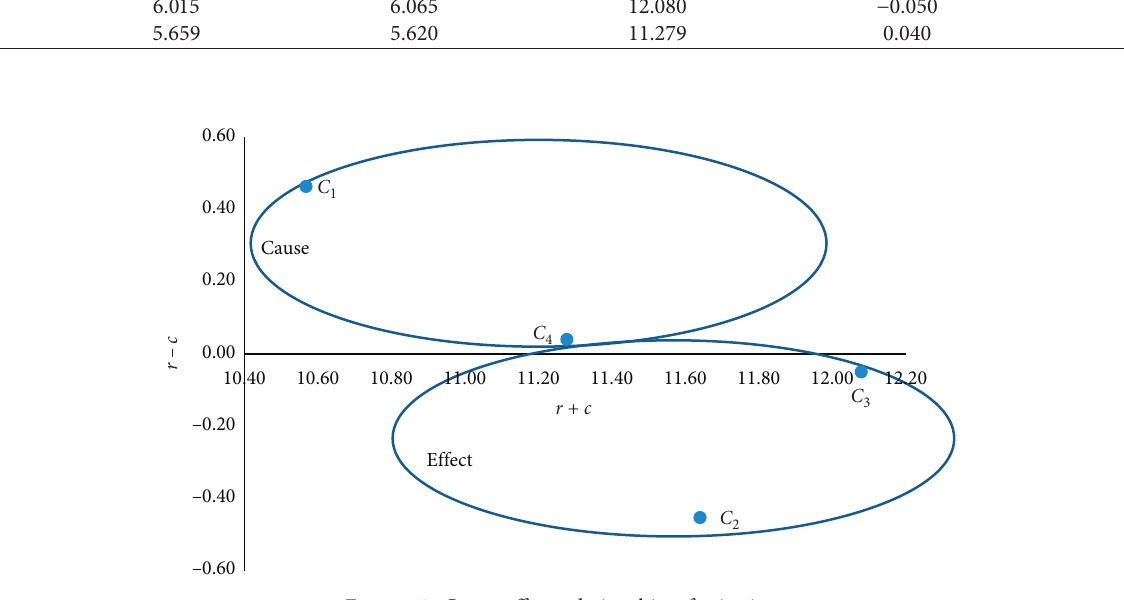
Figure 2: Cause-effect relationship of criteria. Table 6: Decision matrix U .